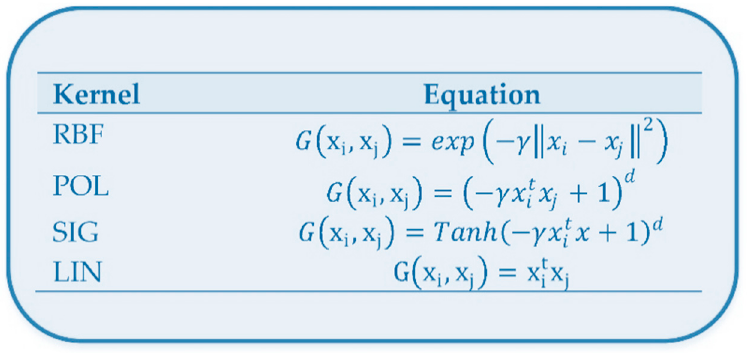
Figure 4. Kernels’